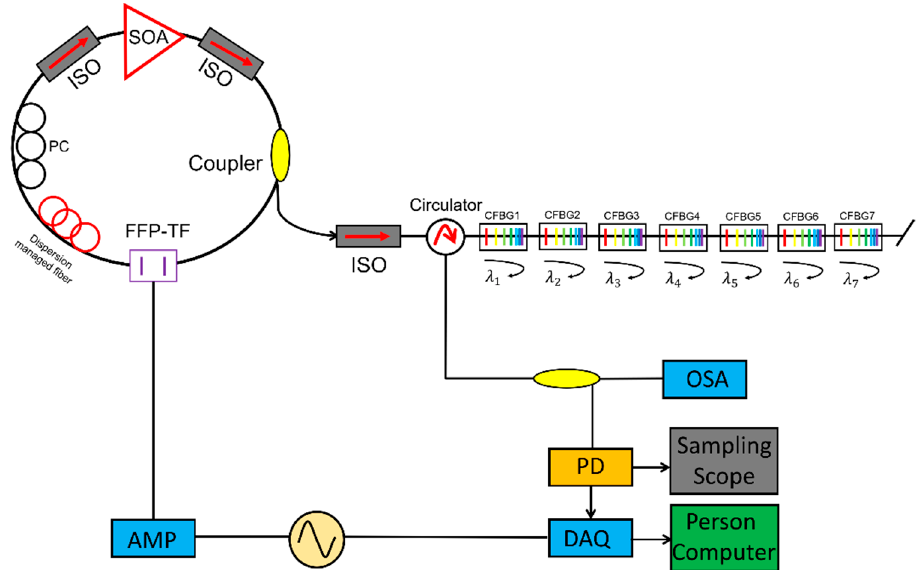
Figure 18. Experimental setup for an FBG sensor array system based on an FDML wavelength-swept laser. Adapted with permission from Ref. [133].